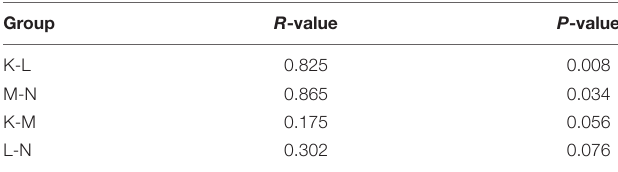
TABLE 4 | Multi-Response Permutation Procedures difference analysis between the four groups of European mouflon and blue